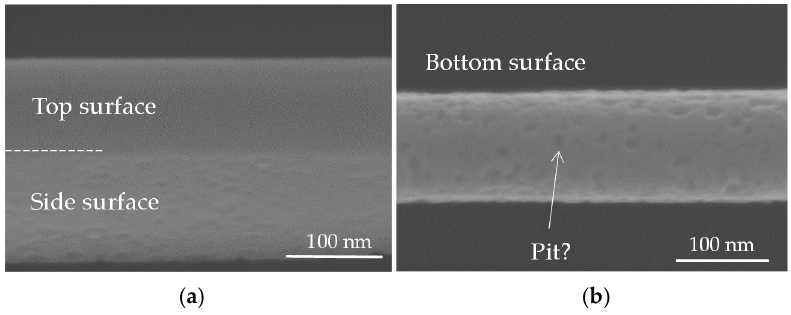
Figure 12. ( a ) Oblique and ( b ) bottom side views of a part of a specimen after tensile testing.